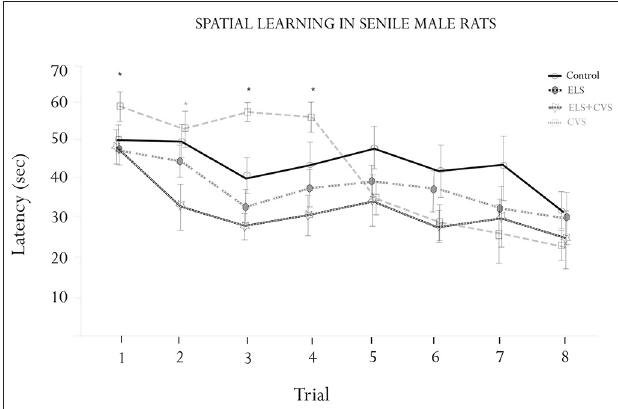
FIGURE 2 | Morris water maze (MWM) assessment. Figure shows the results of the escape latencies across trials (means ± SEM). Significant interactions were found for the escape latency for trials 1, 3 and 4 (* p < 0.05), where the ELS-exposed animals showed increased latencies. A significant interaction was found for trial 2, where the ELS + CVS-exposed animals decreased the latency to find the hidden platform (* p < 0.05). The ELS-exposed rats were no different than the control